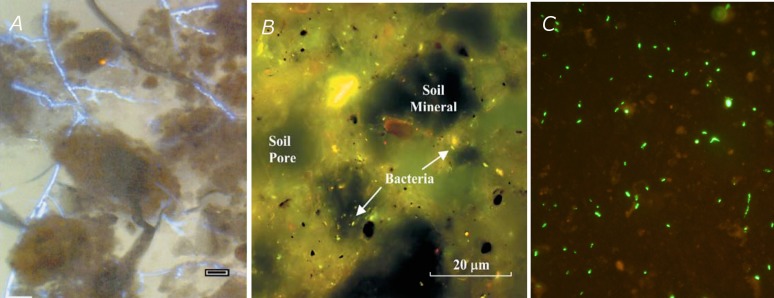
Examples of experimentally determined microbial distribution in soils: (A) microscopic image of hyphae of the fungus Rhizoctonia solani growing in the pore space of a sandy loam. Scale bar 20 μm (Harris et al., 2002. Reproduced with permission of the British Mycological Society). (B) Micrograph of ethidium bromide-stained thin sections of a silt loam soil after inoculation by Escherichia coli. Image obtained using an epifluorescence microscope with blue excitation (Modified from Li et al., 2004. Reprinted with permission). (C) CARD-FISH stained Bacillus subtilis cells in soil filter sections under double excitation filter 643 (465–505 and 564–892 nm) (Modified from Juyal et al., 2018).